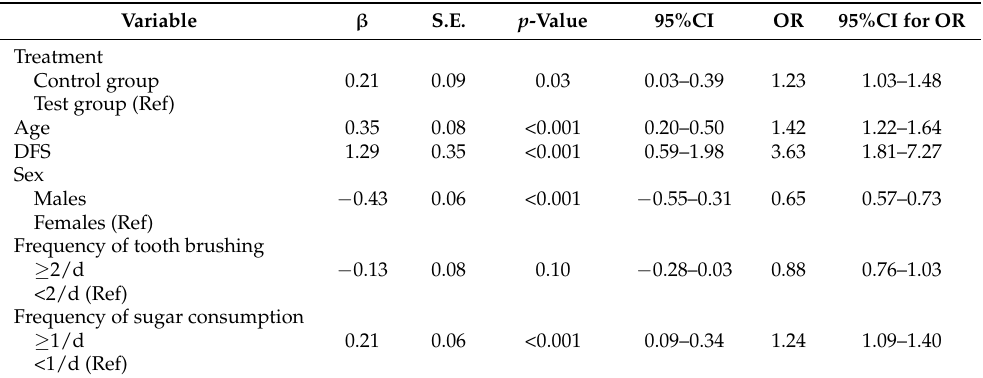
Table 4. Adjusted (generalized linear model) model for dental caries incidence of first permanent molars at the 24-months follow-up examination ( N = 4979 *; class = 107). Variable β S.E.